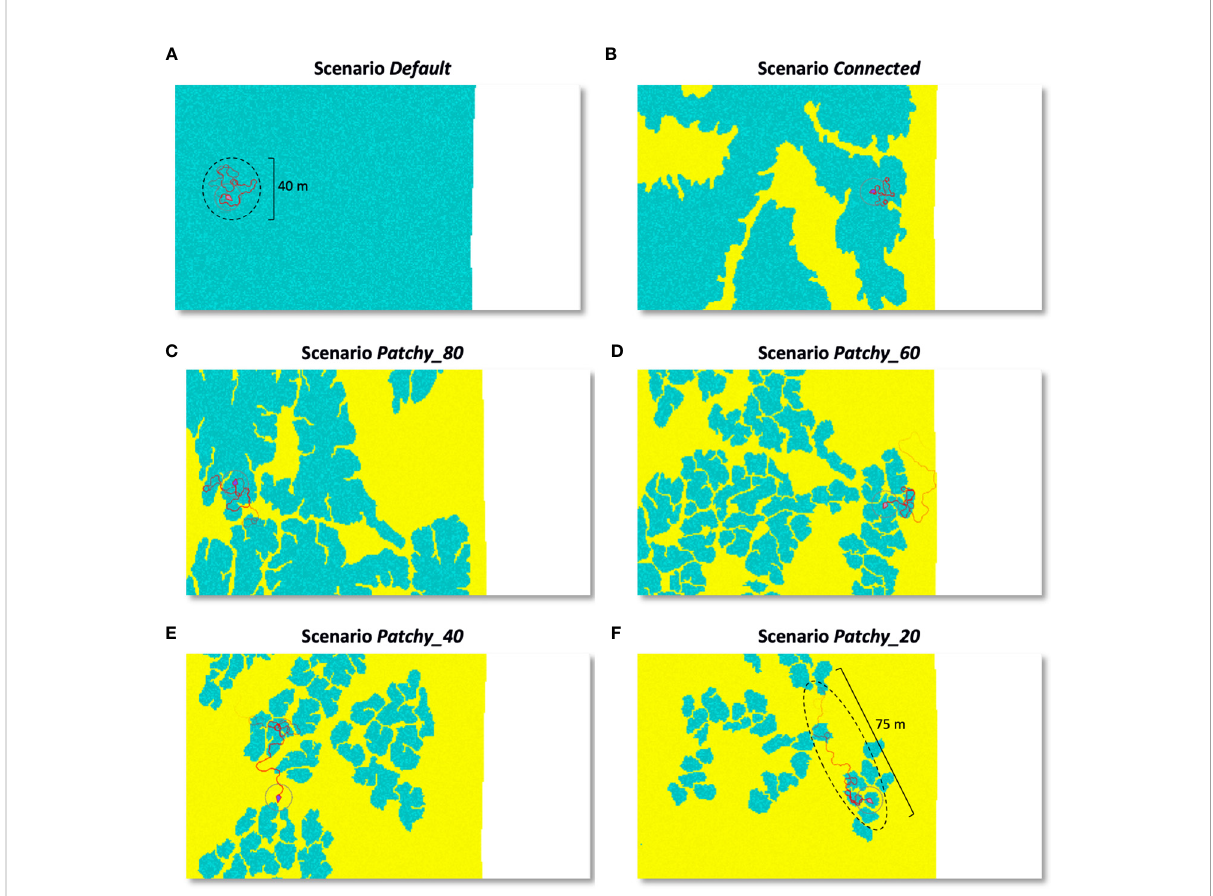
FIGURE 6 Individual movement trails of a (female) model fi sh in its initial phase over a 20 min time period and under different scenarios: (A) scenario Default , (B) scenario Connected , (C) scenario Patchy_80 , (D) scenario Patchy_60 , (E) scenario Patchy_40 , and (F) scenario Patchy_20 . Blue areas = coral reef habitat, yellow = sandy bottom, white area = coastline. Darker shades of a colour indicate higher food availability and circular areas illustrate the fi sh ’ s perception